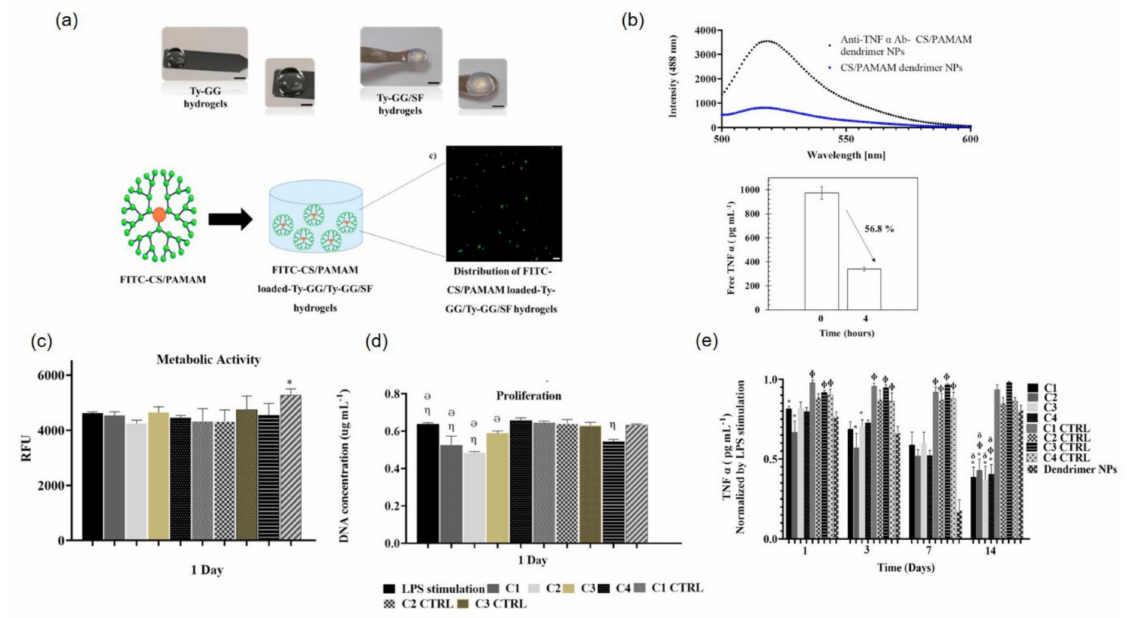
Figure 7. Anti-TNF α monoclonal antibody conjugated-chondroitin sulfate modified poly(amidoamine) dendrimer NP (Anti-TNF α mAb-CS/PAMAM dendrimer NP)-loaded GG-tyr and GG-tyr/SF hydrogel. ( a ) Representative images of GG-tyr and GG-tyr/SF hydrogel, where the fluo- rescence image shows a uniform distribution of NPs throughout the hydrogel. ( b ) Anti-TNF- α mAb conjugation to CS/PAMAM dendrimer NP. Effect of the hydrogel on THP-1 cell-based inflammation model, ( c ) metabolic activity, and ( d ) DNA concentration. ( e ) Measurement of the free TNF- α levels in cell culture media demonstrates that the anti-TNF α mAb-CS/PAMAM dendrimer NP-loaded hydrogel maintained cell viability, induced cell proliferation, and retained the capacity to neutralize TNF- α , even after 14 days. Adapted from [166] under the terms of the creative common attribution license, MDPI, 2021.